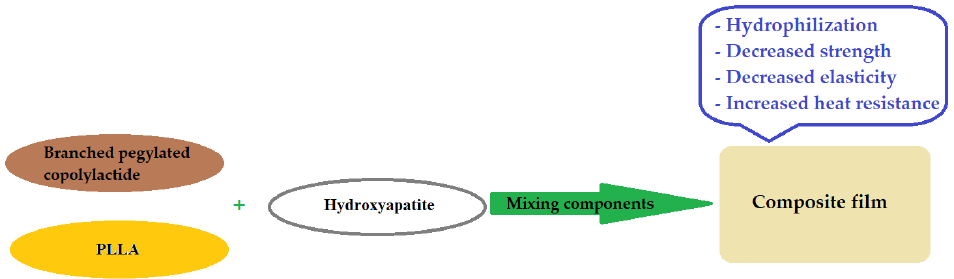
Figure 1. The preparation and development of properties of polylactide composite materials filled with